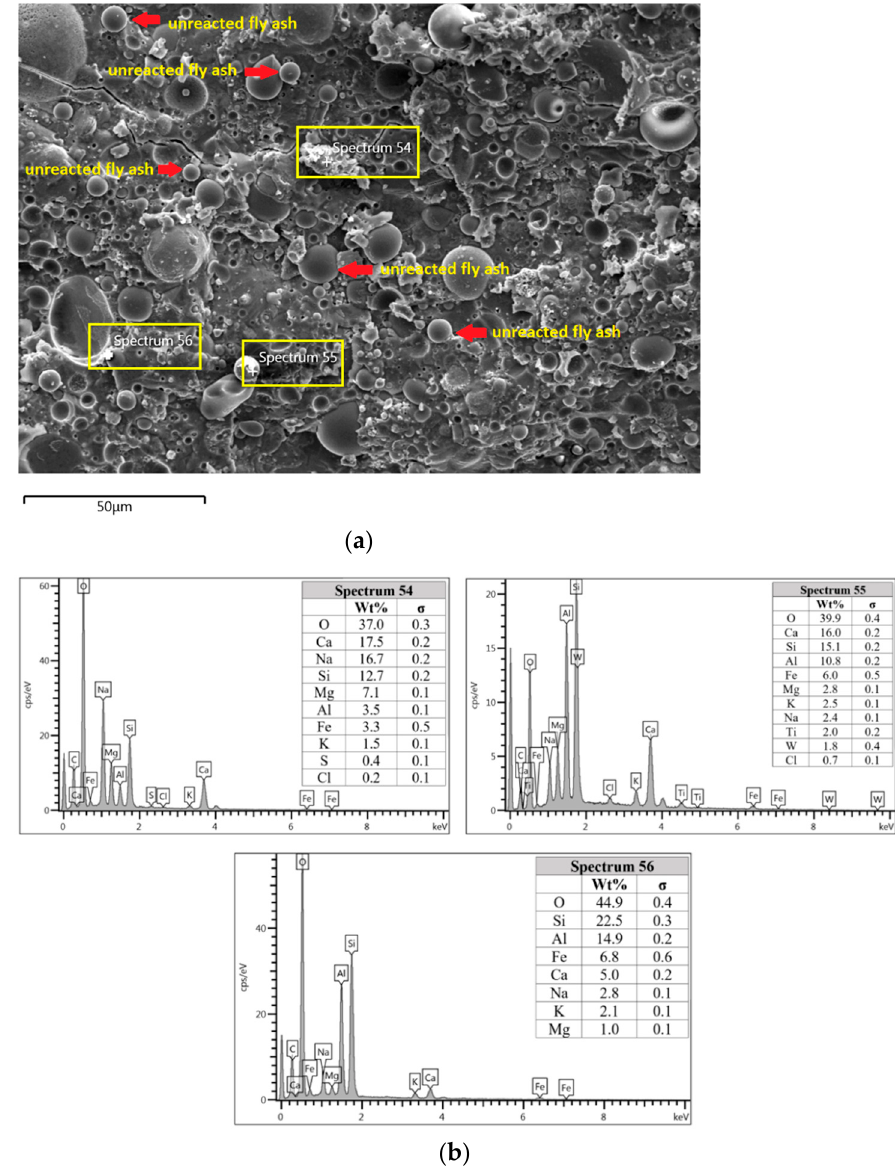
Figure 9. ( a ) Morphology of AAFA specimens cast in lake water. ( b ) EDS for AAFA specimens cast in lake water